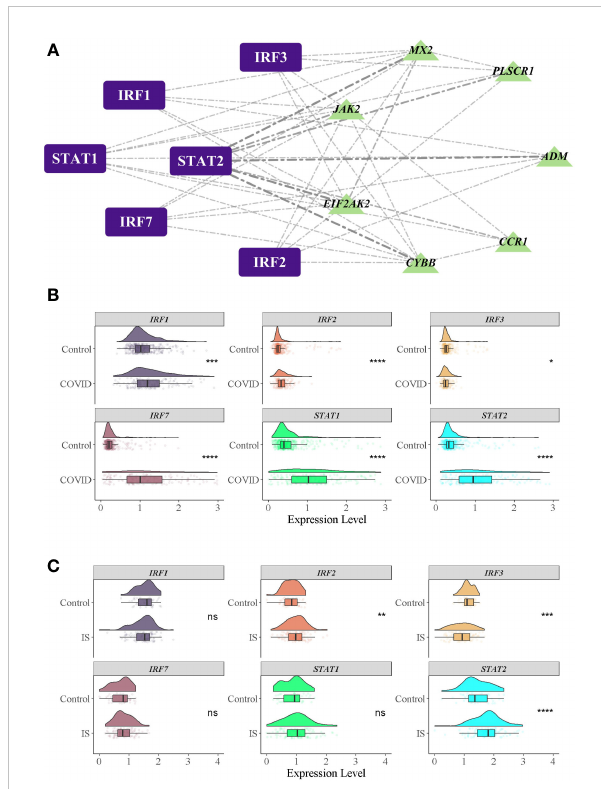
FIGURE 6 TFs regulatory network and their gene expression pro fi les in COVID- 19/IS. (A) Inferring TF regulatory networks. TFs were marked in purple, and the common IDEGs were marked in green. (B, C) Gene expression level of TFs in COVID-19 and IS datasets. The comparison of gene expression between patients and controls was applied with t-test. P-value < 0.05 was considered statistically signi fi cant. COVID-19, Corona virus disease 2019; IS, ischemic stroke. *:P < 0.05; **:P < 0.01; ***:P < 0.001; ****:P <